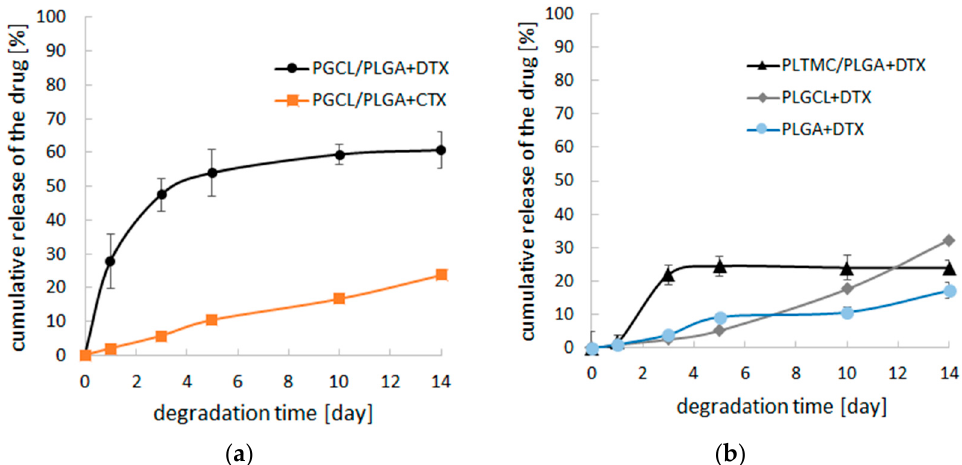
Figure 2. Cumulative release of drug-loaded patches during 14 days of incubation in PBS pH = 7.4 (n = 3); ( a ) (PGCL/PLGA) + DTX and (PGCL/PLGA) + CTX patches; ( b ) (PLTMC/PLGA) + DTX, PLGCL + DTX and PLGA + DTX patches.